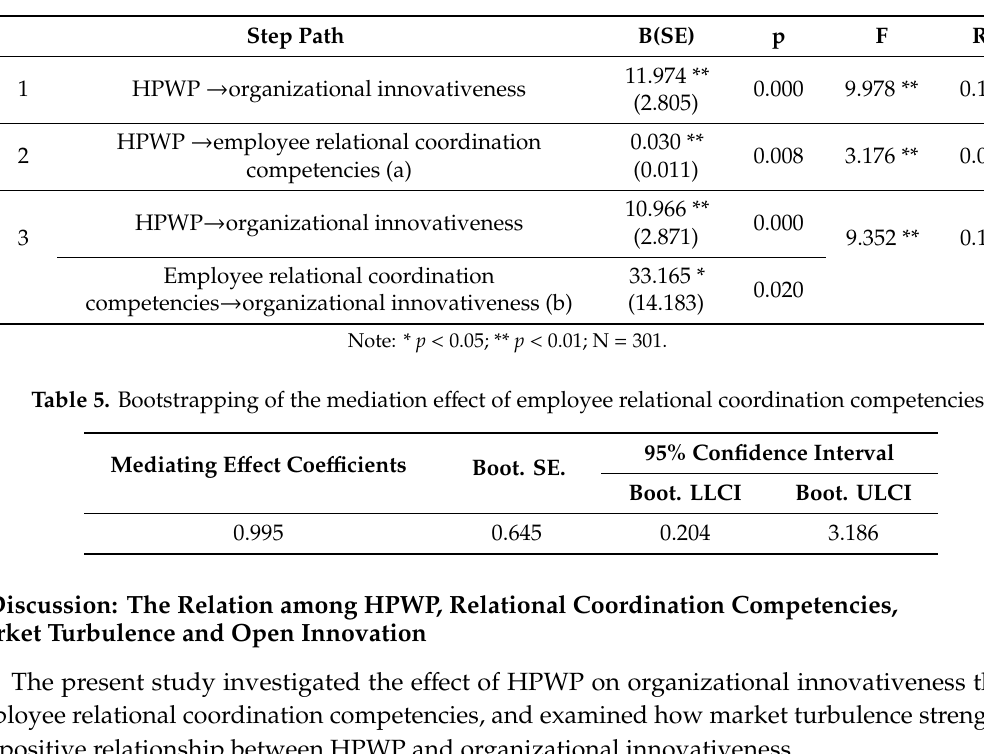
Table 4. Mediation analysis results for H2.